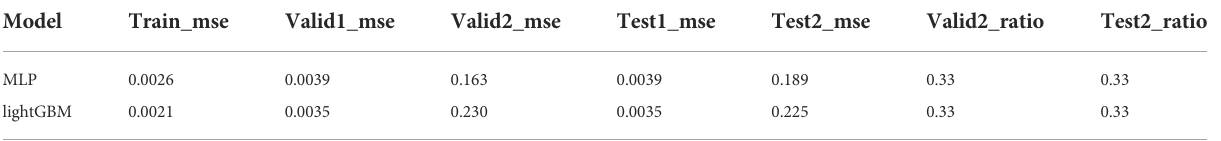
TABLE 4 Model performance without additional positive sample.